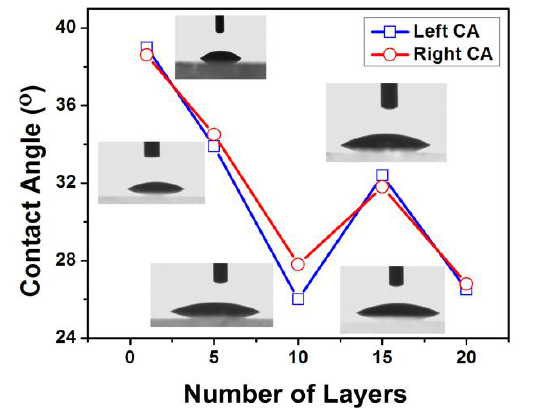
Figure 3. Water contact angles (CA) for PDDA/PAA multilayer films.